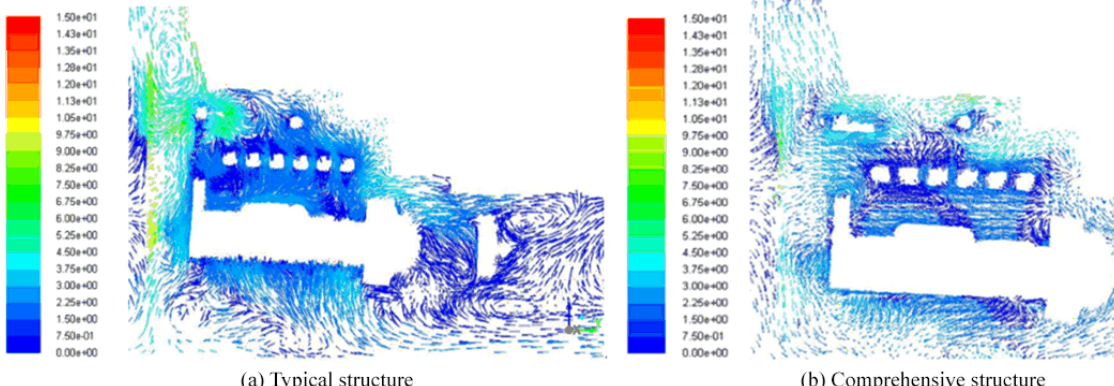
Figure 10. Comparison of velocity fields within the plane X = 148mm (unit: ms − 1 ).